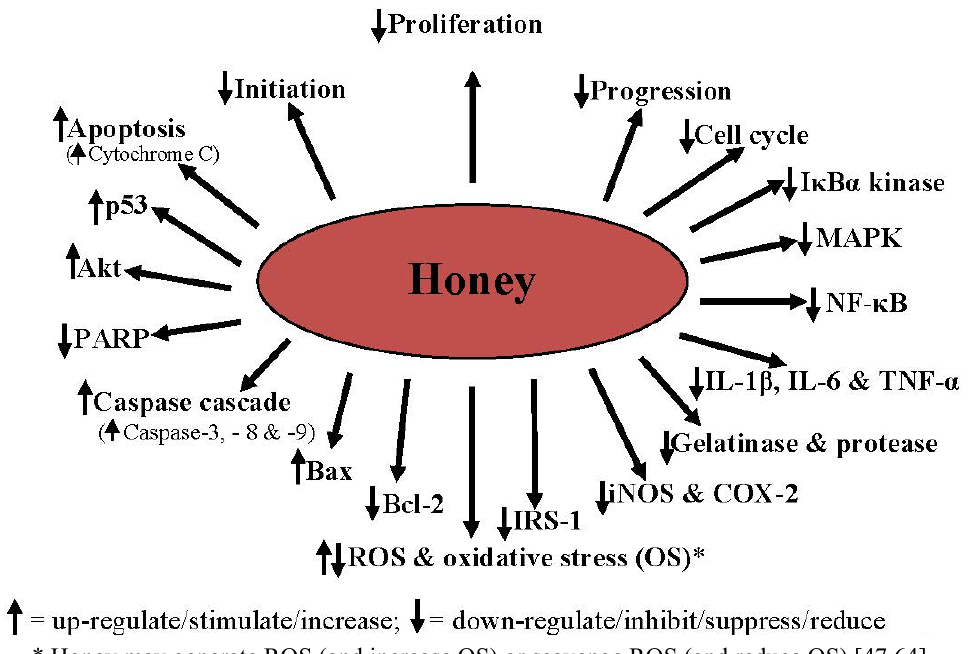
Figure 5. Molecular mechanisms/targets mediating the antiproliferative, antitumor, antimetastatic and anticancer effects of